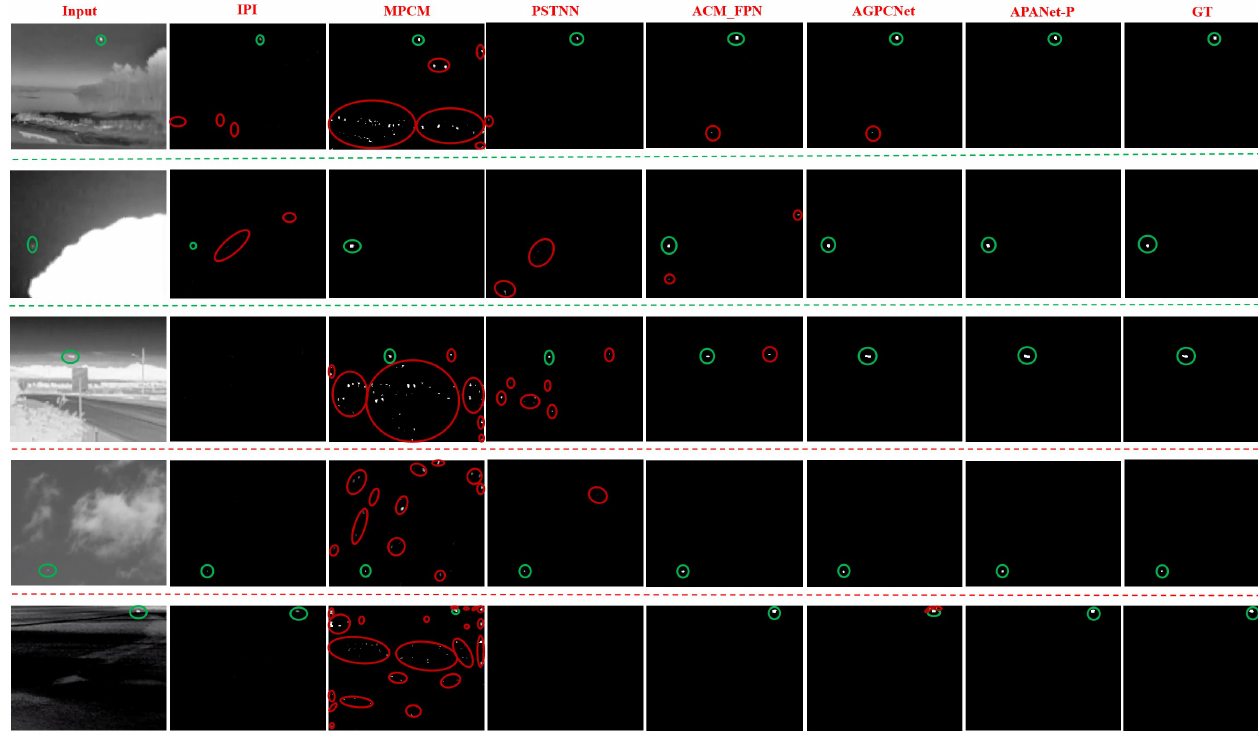
Figure 8. Qualitative outputs of different small infrared target detection